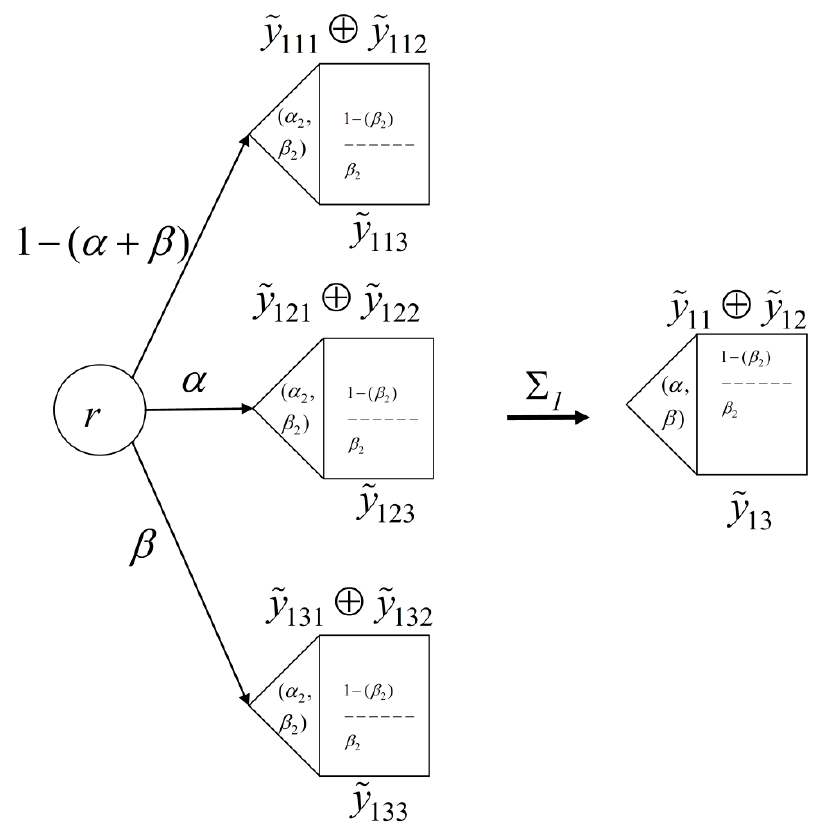
Figure 4. Nested aggregation of parameterized model.